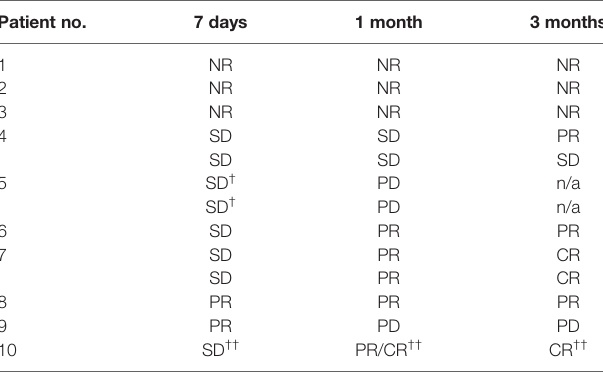
TABLE 4 | Tumor response at 7 days, 1 month and 3 months post FLASH-RT, estimated based on the veterinary RECIST 1.0 criteria for patients with solid tumors, and disease-free interval for patients with microscopic disease. Patient